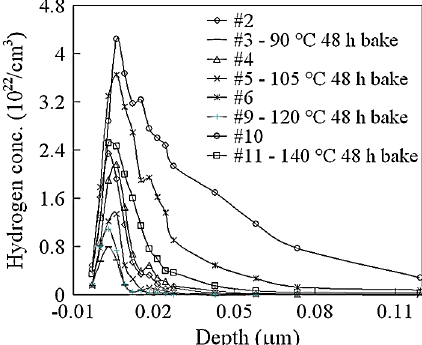
FIG. 7. Hydrogen concentration as a function of depth from the surface of Nb samples prepared by BCP, before and after low-temperature baking in UHV, as measured by NRA. The figure is taken from Ref.